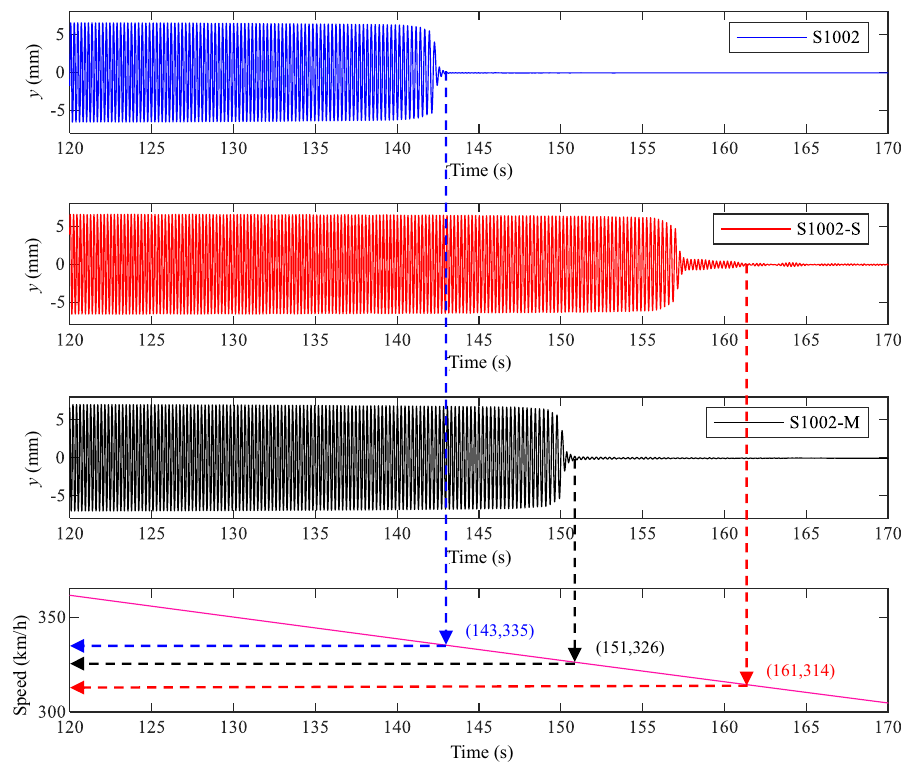
Fig. 19 Simulation runs of S1002, S1002-S and S1002-M through the deceleration